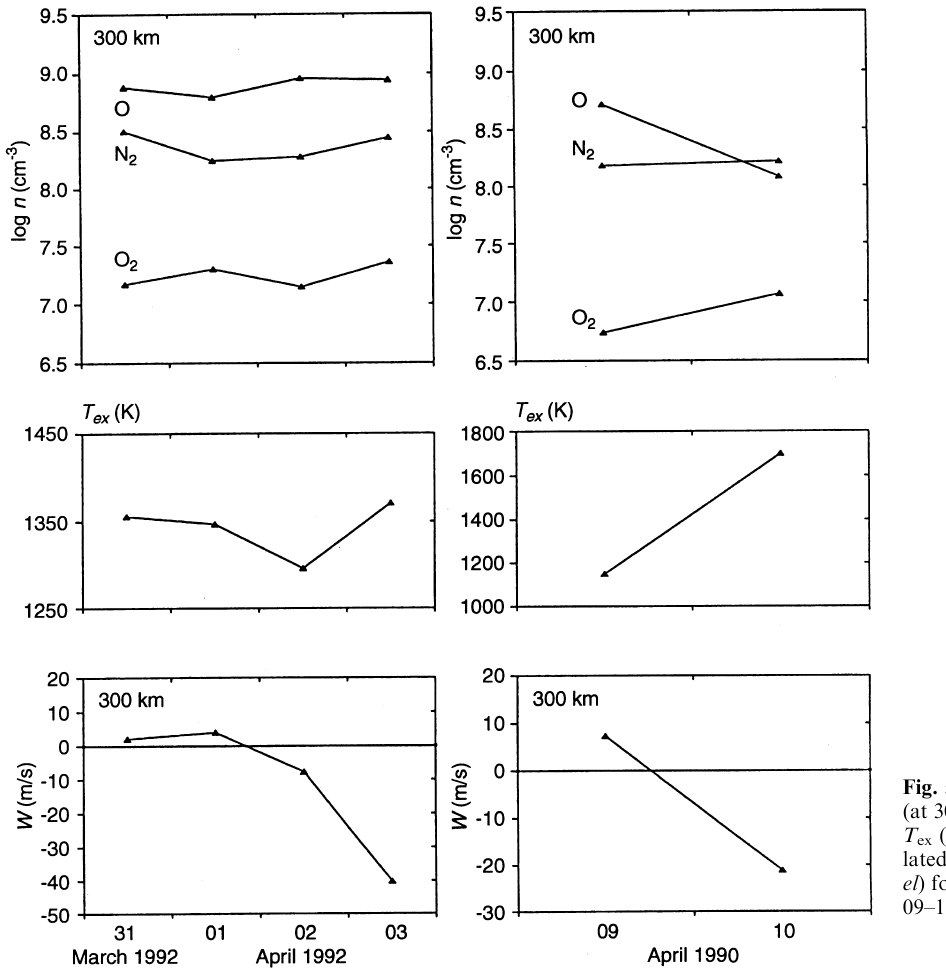
Fig. 5. Calculated neutral composition (at 300 km) and exospheric temperature T ( top and middle panels ) and calcu- ex lated vertical plasma drift ( bottom pan- el ) for 31 March–3 April 1992 ( left ) and 09–10 April 1990 (